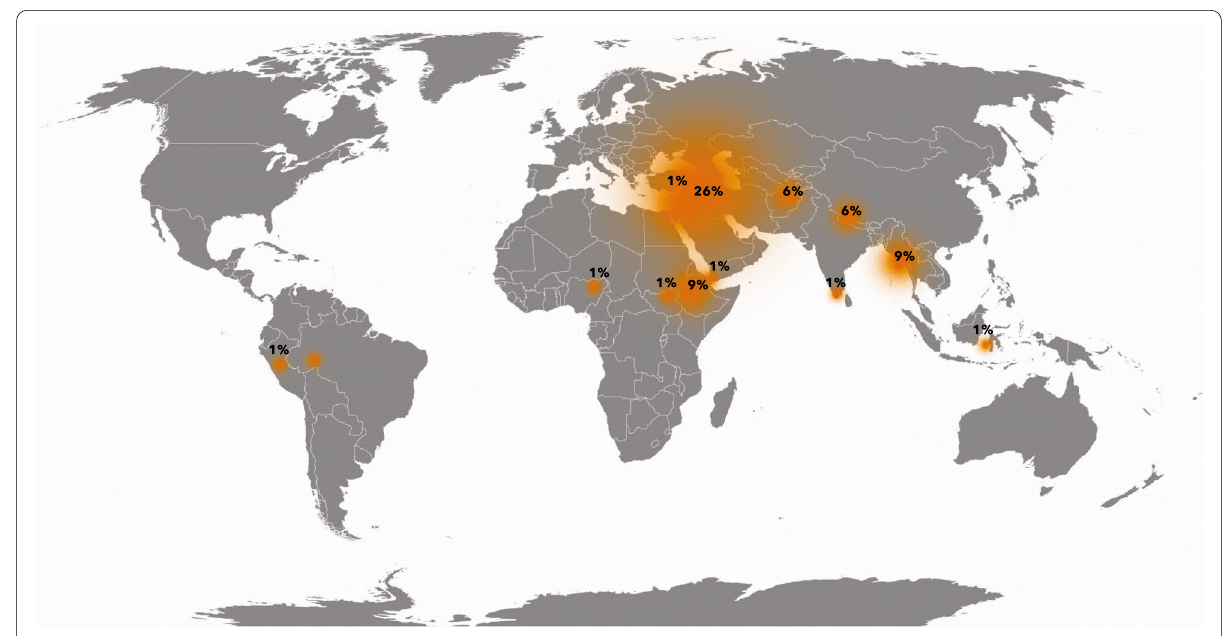
Fig. 3 Percentage distribution of included papers over the